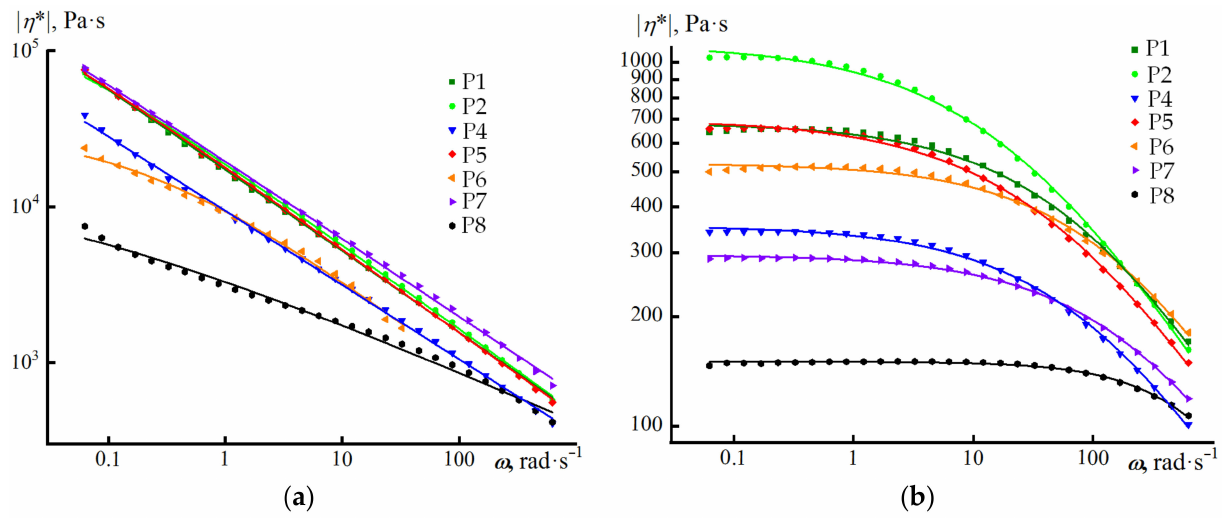
Figure 3. Frequency dependences of the complex viscosity at 130 ( a ) and 190 ◦ C ( b ). The polymer numbers are presented in the legends. The dots show the experimental data, while the lines represent their fitting using the Cross